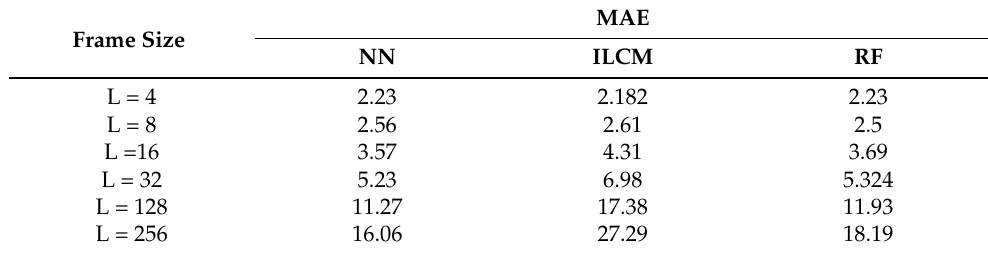
Table 6. MAE of NN, RF and the ILCM model for a particular frame size. Frame